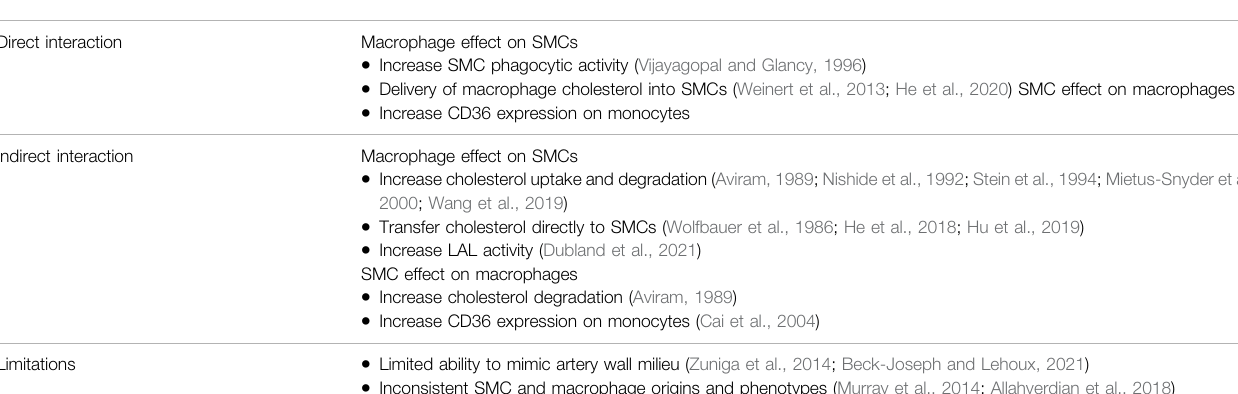
TABLE 2 | Summary of potential SMC-macrophages interactions in foam cell development.